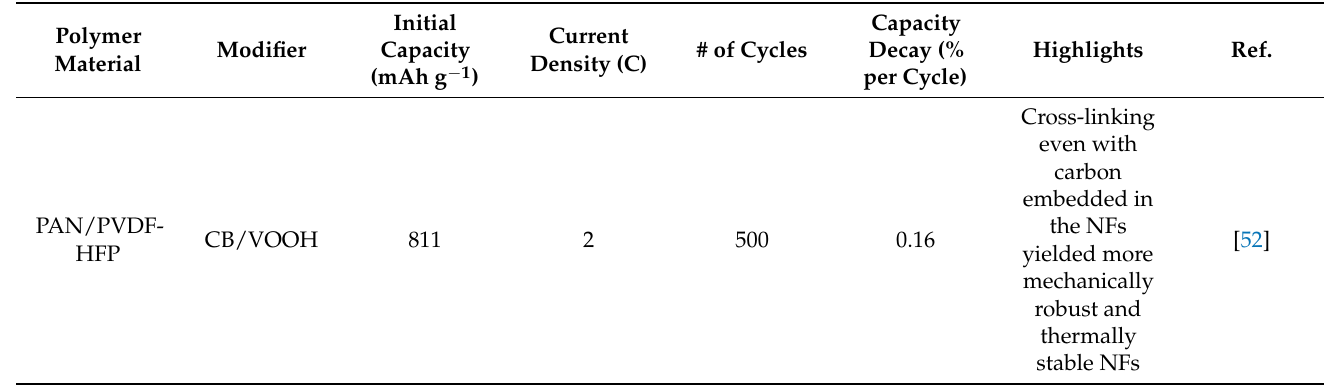
Table 2. The performance and notable developments of LSBs with various modifiers in order of carbon, metal oxide, MOF, and alternative